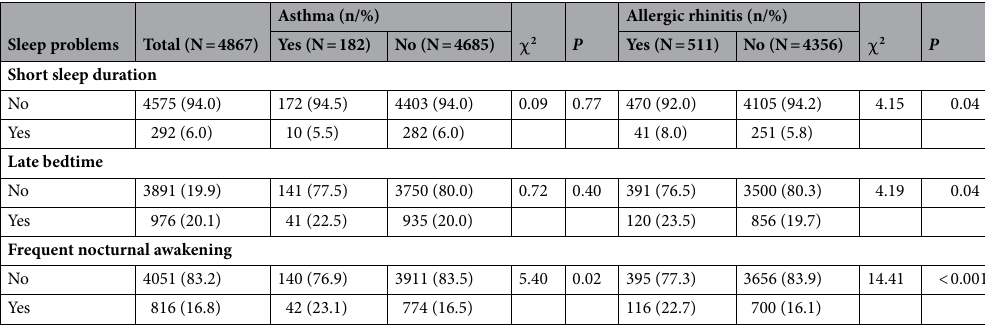
Table 2. Frequency and proportion of sleep problems by asthma and allergic